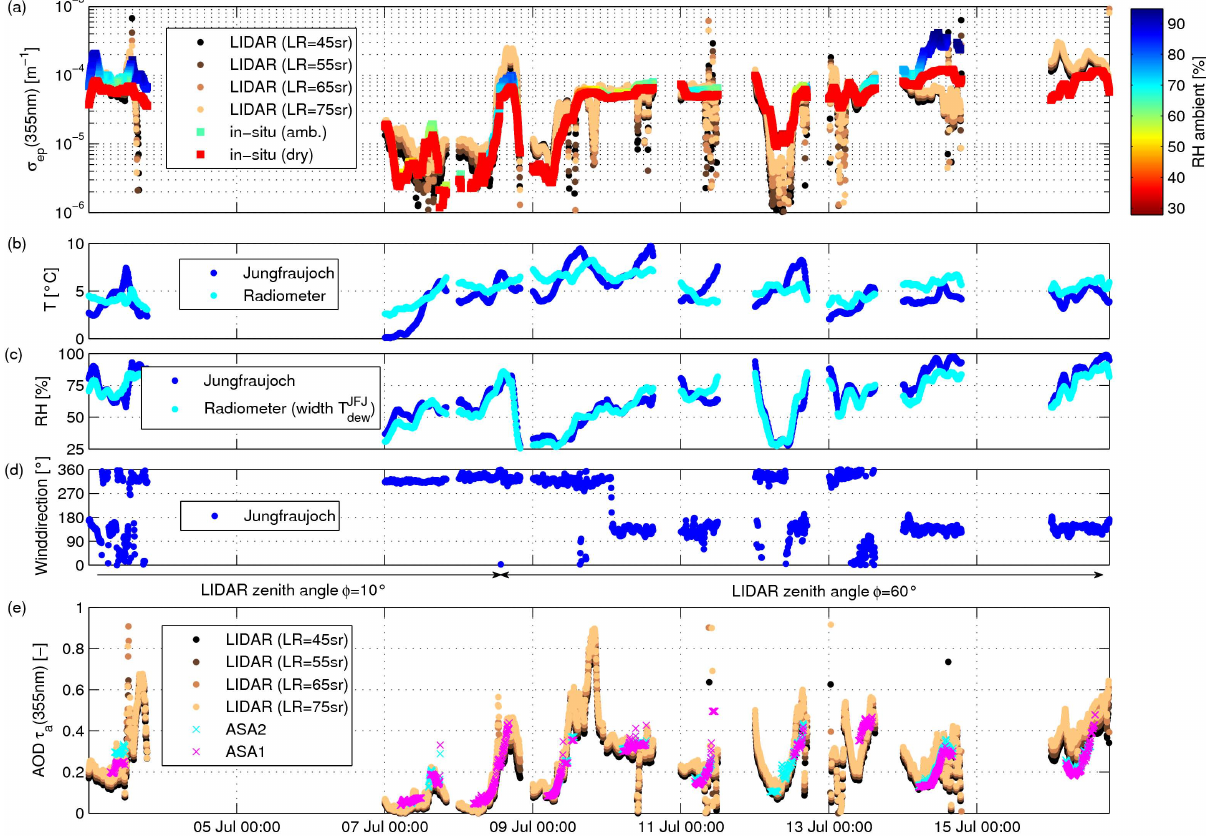
Fig. 5. (a) Time series of the aerosol extinction coefficient (at λ = 355nm) measured in-situ at Jungfraujoch (JFJ) (red bullets: dry, colored squares: at ambient RH indicated in the color bar) and by the LIDAR at the altitude of the JFJ (Point C and D in Fig. 1) by assuming different LIDAR ratios (see legend). (b) Ambient temperature at the JFJ (dark blue bullets) and retrieved from radiometer measurements from the Kleine Scheidegg (KLS) here at the height of the JFJ (light blue bullets). (c) Ambient relative humidity at the JFJ (dark blue bullets) and retrieved from radiometer measurements from the KLS at the height of the JFJ (light blue bullets) using the measured dew point temperature of the JFJ and the Magnus formula. (d) Wind direction measured at the JFJ. (e) The aerosol optical depth (AOD) retrieved from the LIDAR at different LIDAR ratios and measured by the Sun photometers FUBISS-ASA1 (magenta crosses) and FUBISS-ASA2 (cyan crosses). The LIDAR was operating with two different zenith angles (10 ◦ and 60 ◦ , see